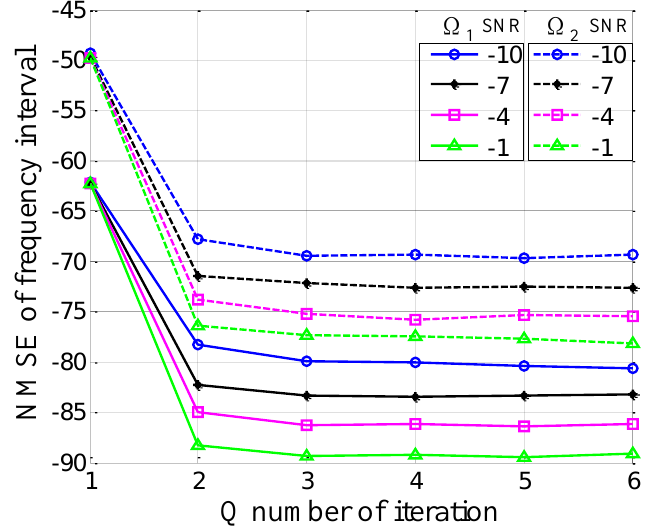
Figure 2. NMSE of f ∆ for signals Ω 1 and Ω 2 versus the number of